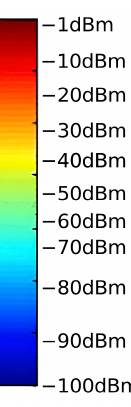
Figure 11. RTg heat map of antenna 2 ( a ) and Multi-Wall heat map ( b ) (taken from [11]).